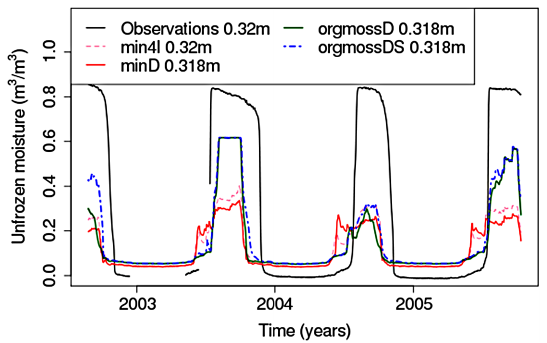
Figure 9. Simulated and observed soil moisture at approximately 32cm depth. The simulations include the standard JULES set-up (min4l) and show the effects of a deeper and better-resolved soil (minD), adding organic soils and moss (orgmossD) and improving the snow scheme (orgmossDS). Observations are from a polygon